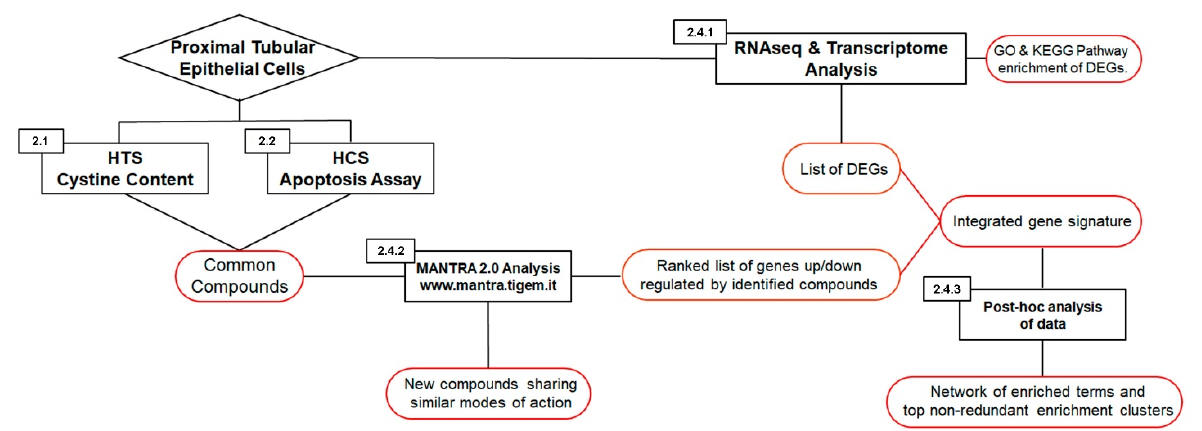
Figure 1. Flow diagram of the study.